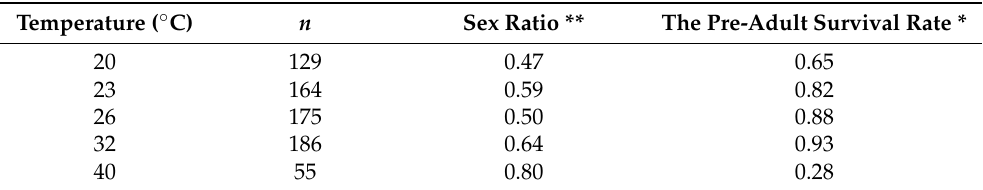
Table 2. Sex ratio (proportion of females) and nymphs mortality rates of D. opuntiae population under different constant temperatures (20, 23, 26, 32, and 40 ◦ C).